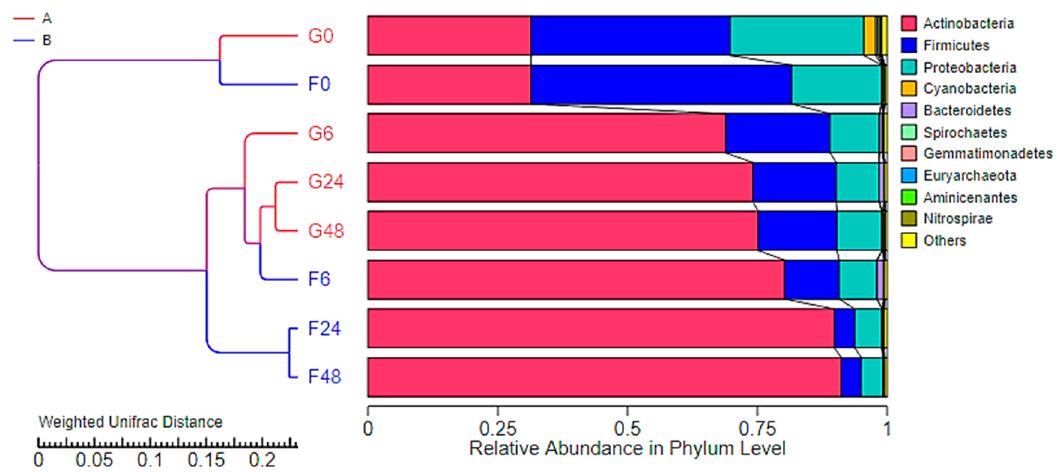
Figure 9. UPGMA cluster tree based on weight unifract distance, revealing the relative abundance in the phylum for the fermentation of inulin-FOSs extract and that of glucose.